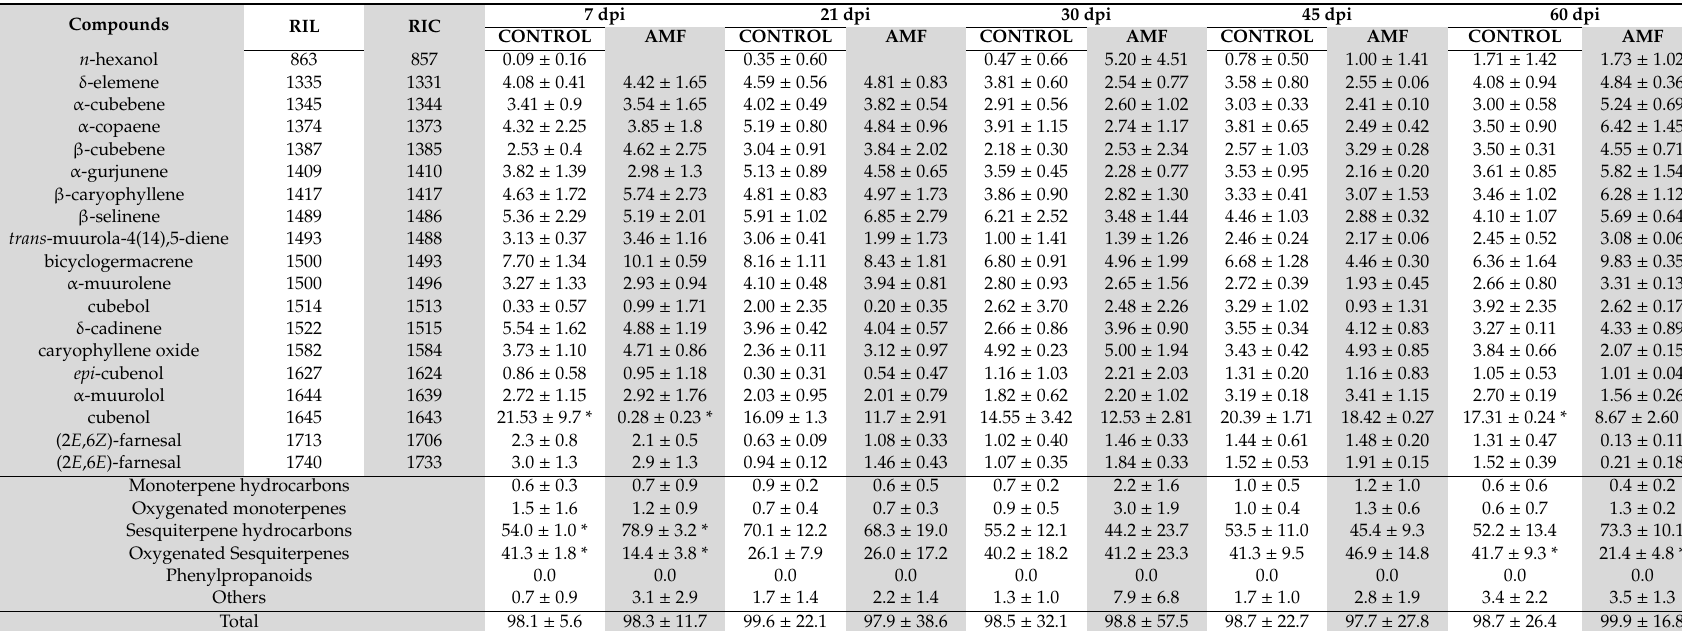
Table 1. Comparison of volatile compounds produced in Piper nigrum leaves non-inoculated and inoculated with arbuscular mycorrhizal fungi (AMF) (mean ± standard